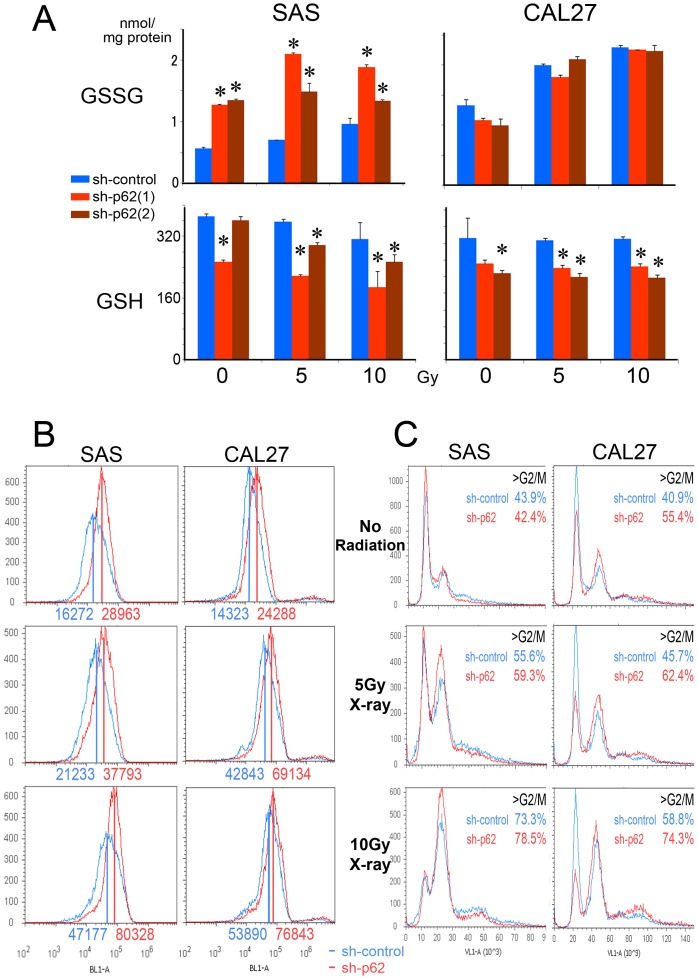
GSH cannot be induced by the irradiation, and ROS accumulate in p62/SQSTM1 knockdown cells.(A) GSSG (upper) and GSH (lower) levels of shRNAs (sh-control, sh-p62(1) and sh-p62(2); blue, red and brown columns, respectively) -treated cells are indicated by bar chart. In each graph, the left 3 columns indicate the data of no radiation. The middle 3 and right 3 columns indicate the data of 5-10 Gy X-ray irradiation followed by 24h culture. Although GSH was maintained in sh-control cells, it was significantly reduced in sh-p62(1) and sh-p62(2) cells. The values are derived from triplicate experiments (*, p<0.05, one-way factorial ANOVA and multiple comparison tests accompanied by Scheffe's significance test). (B) ROS levels were detected with CellROX® Green reagent in sh-control and sh-p62 cells, under no radiation (upper) and 5 (middle) - 10 (lower) Gy X-ray irradiation. ROS levels in p62/SQSTM1 knockdown cells (red lines) were higher than in control cells (blue lines). Numbers indicate mean fluorescent values. (C) DNA contents were evaluated with Hoechst 33342 reagent in sh-control and sh-p62 cells, under no radiation (upper) and 5 (middle) - 10 (lower) Gy X-ray irradiation. The more cells were irradiated, the more prominently >G2/M phase cell fractions were accumulated. The accumulation was more prominent in p62/SQSTM1 knockdown cells (sh-p62; red lines) than in the control cells (sh-control; blue lines). Sub-G1 apoptotic fractions could not be detected. Left and right panels indicate the data on SAS and CAL27 cells, respectively.